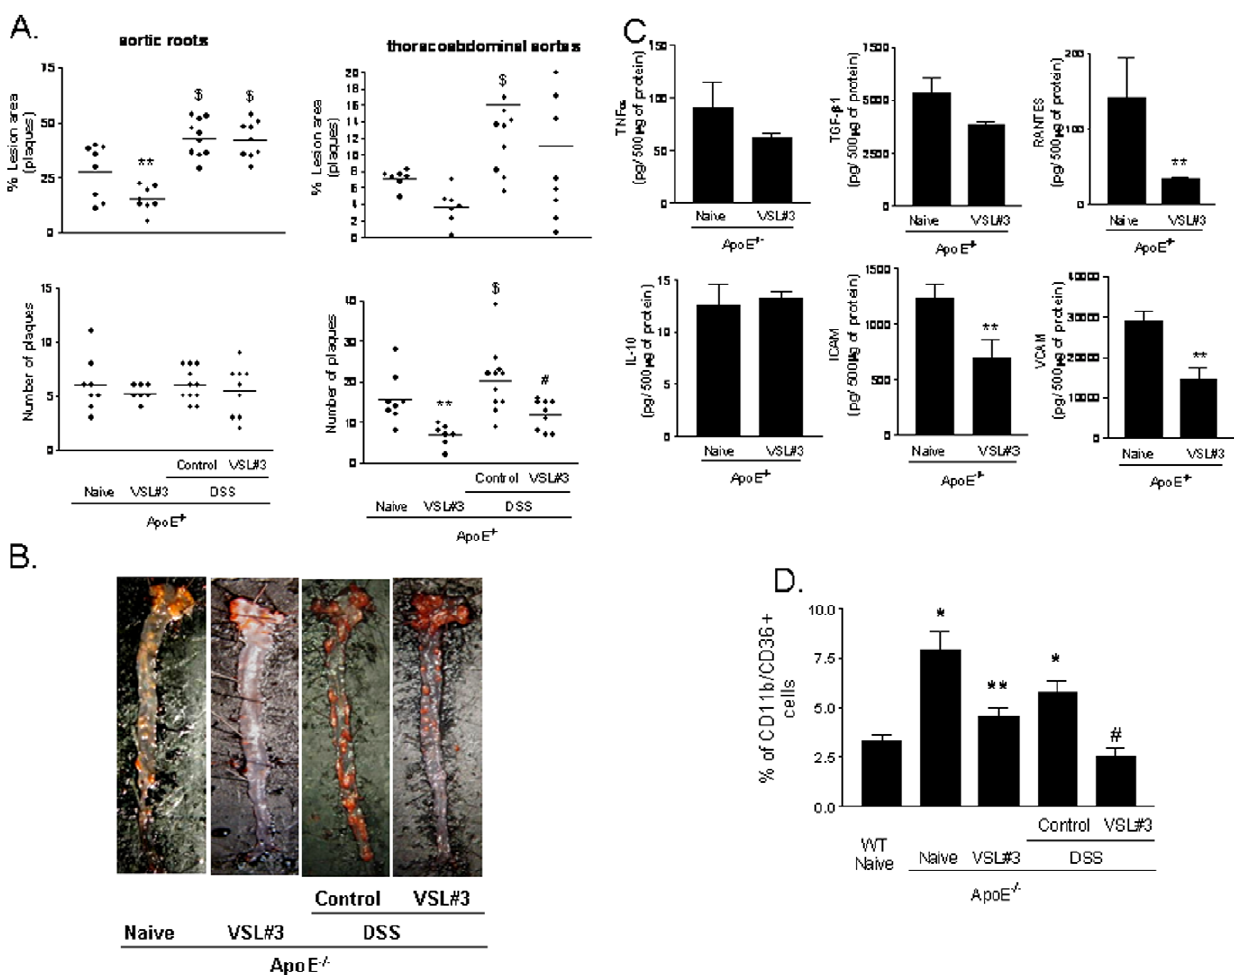
Figure 5. Effect of VSL # 3 administration on atherosclerosis development in ApoE 2 / 2 mice. Panel A. Administration of DSS to ApoE 2 / 2 for 12 weeks increases the size of aortic plaques (ratio of plaque surface area to vessel surface area) and numbers of plaques. Individual data are shown n=7–12. Panel B. Representation of aortic plaques from individual animals. The images shows the plaque surface from individual animals, each one representative of a specific experimental group. The lipids in the vessel wall were staining with Sudan IV. Panel C. Aortic concentration of TNF a , TGF- b 1, RANTES, IL-10, ICAM-1 and VCAM. Data are mean 6 SE of n=5 mice per group. D ) VSL # 3 intervention reduced the percentage of CD36 positive cells on circulating macrophages. The mean 6 SE of n=5 mice per group is shown. * p , 0.05 ApoE 2 / 2 experimental group versus naive wild type group; ** p , 0.05 ApoE 2 / 2 naı¨ve group versus ApoE 2 / 2 plus VSL # 3 group; $ p , 0.05 ApoE 2 / 2 naive group versus ApoE 2 / 2 plus DSS group; # p , 0.05 ApoE 2 / 2 plus DSS group versus ApoE 2 / 2 plus DSS and VSL # 3